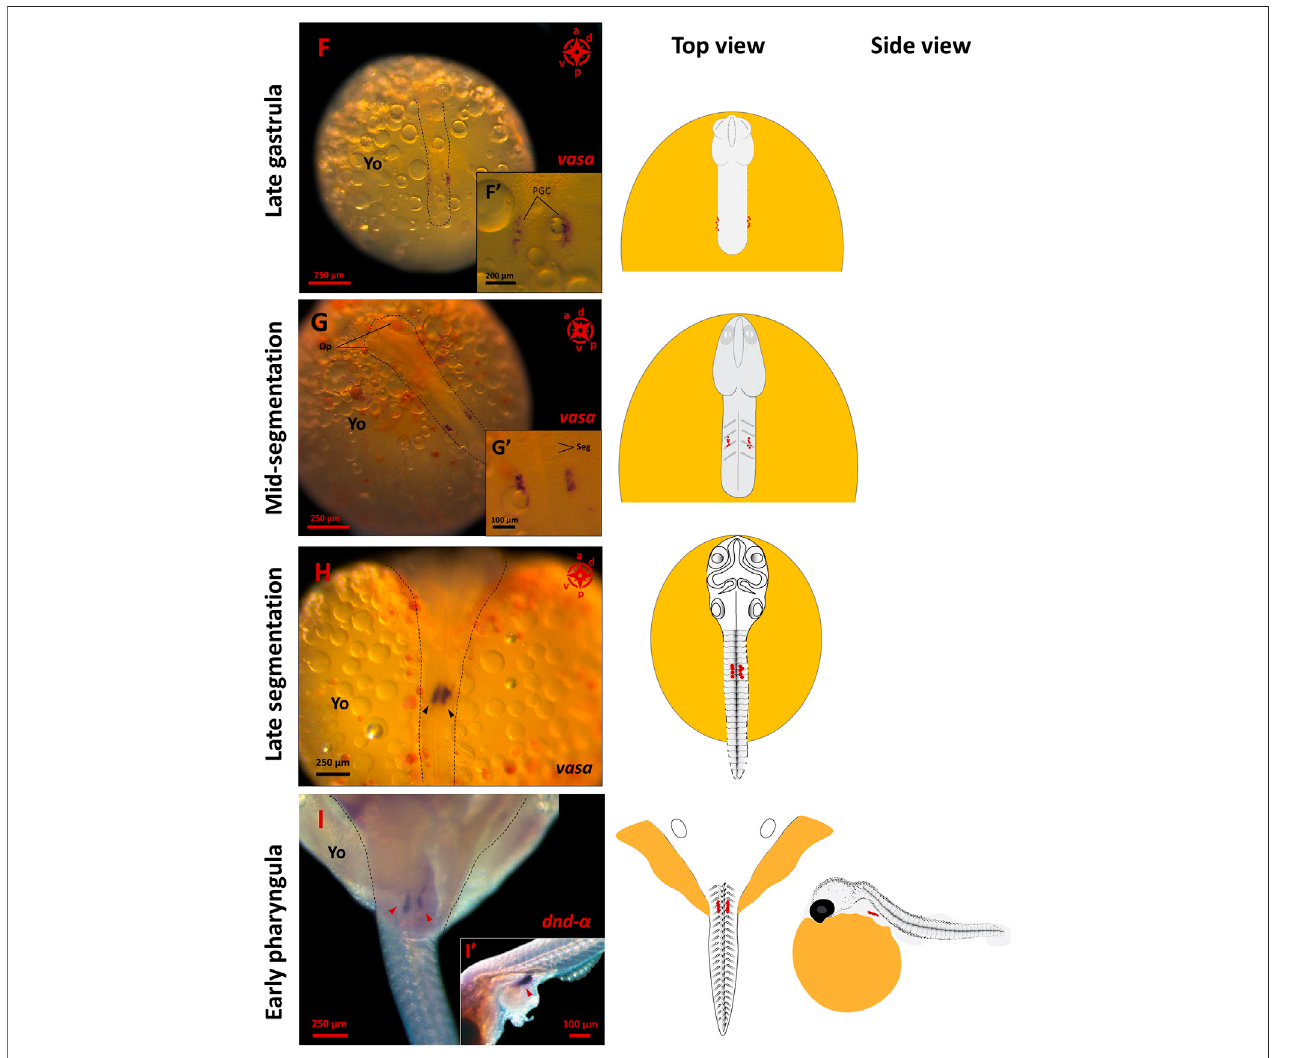
( Figure 2A ). As for the embryonic expression, two of which were detected in the posterior ( vasa and dnd- α ) and anterior (